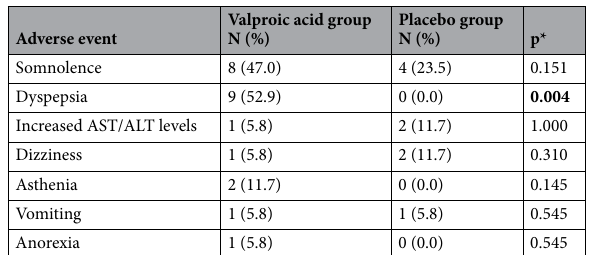
Table 3. Main adverse events of the study in decreasing order of reporting. *Calculated by the proportion difference test. p-value < 0.05 is presented in bold.